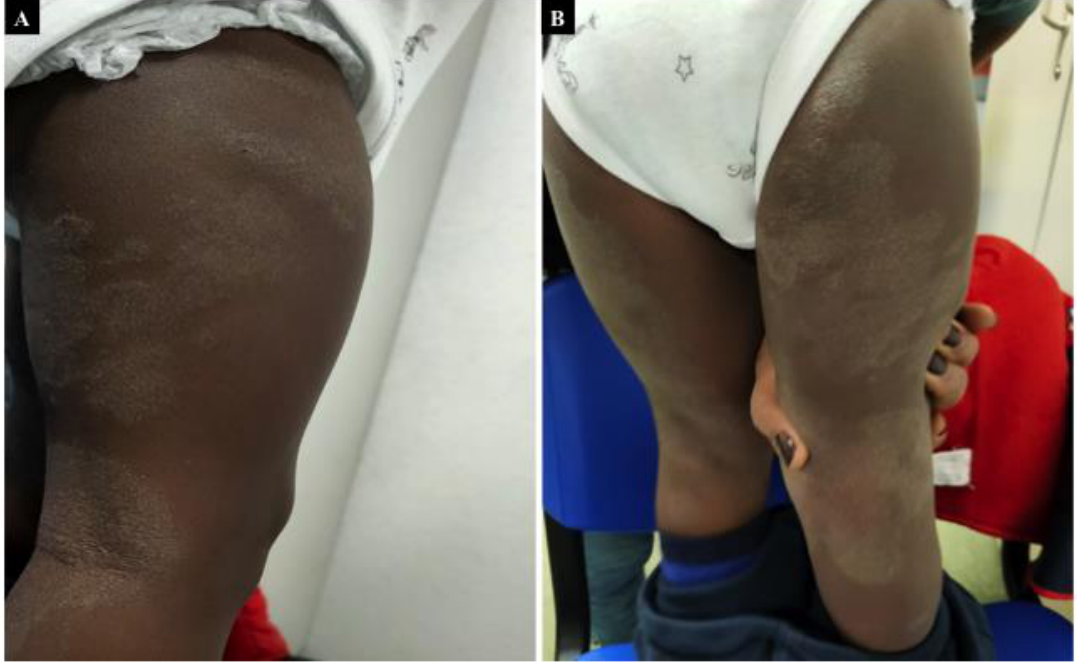
Figure 3. Atopic Dermatitis. ( A , B ) erythema, lichenification, scaling, and prurigo in a 6 years old child. Excoriated bilateral erythematous scaling papules and plaques on the surface of the lower limbs.